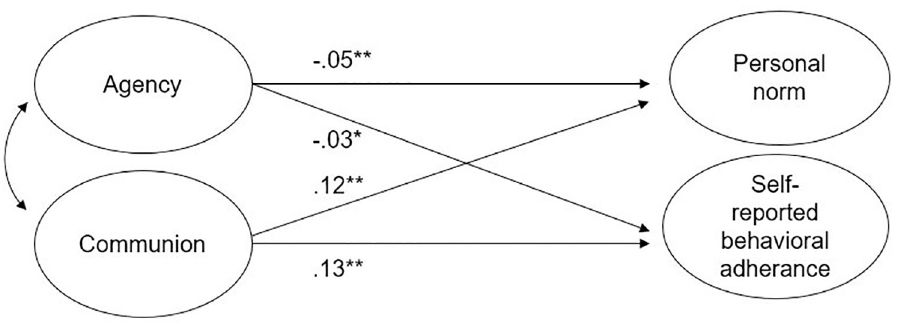
Fig 1. Structural equation model predicting personal norm and self-reported behavioral adherence to COVID measures (Model 1). This SEM predicts personal norm and self-reported behavioral adherence to COVID measures from adolescents’ agentic and communal orientation. Statistics are standardized regression coefficients. � p < .05 �� p <